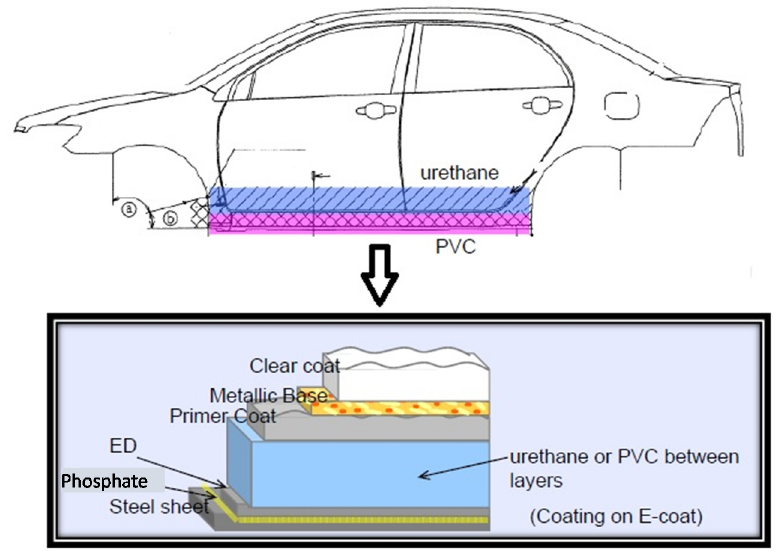
Figure 6. The anti ‐ chipping material coating on lower doors and rocker panels. Figure 6. The anti-chipping material coating on lower doors and rocker